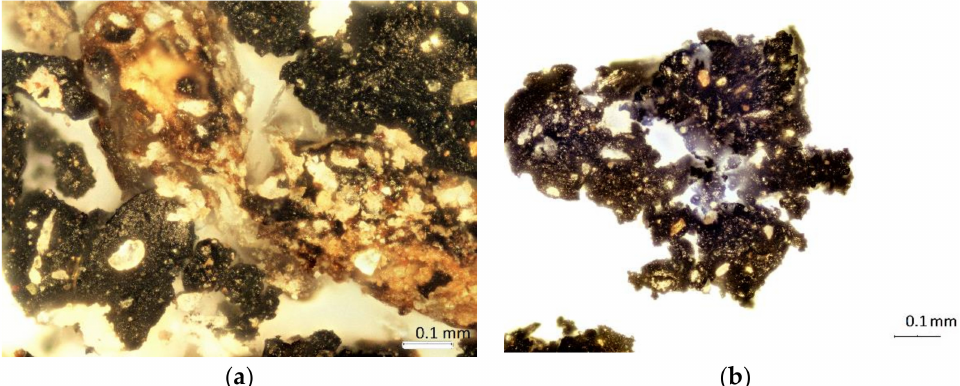
Figure 4. FTIR microscope imaging of microplastics with 100 magnification. Samples extracted from ( a ) road dust, ( b )